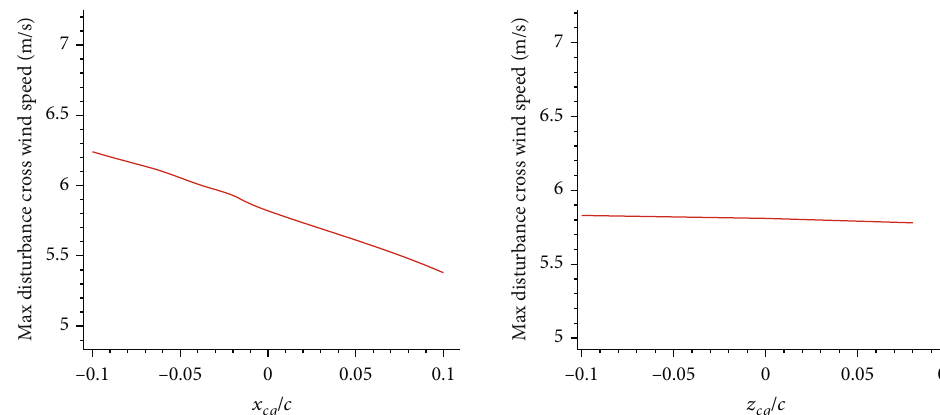
Figure 36: In fl uence of the CG position on the wind disturbance rejection